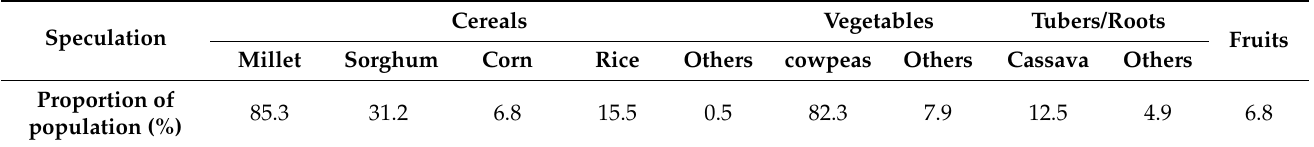
Table 2. Production rate of speculations by the populations of the surveyed communities.